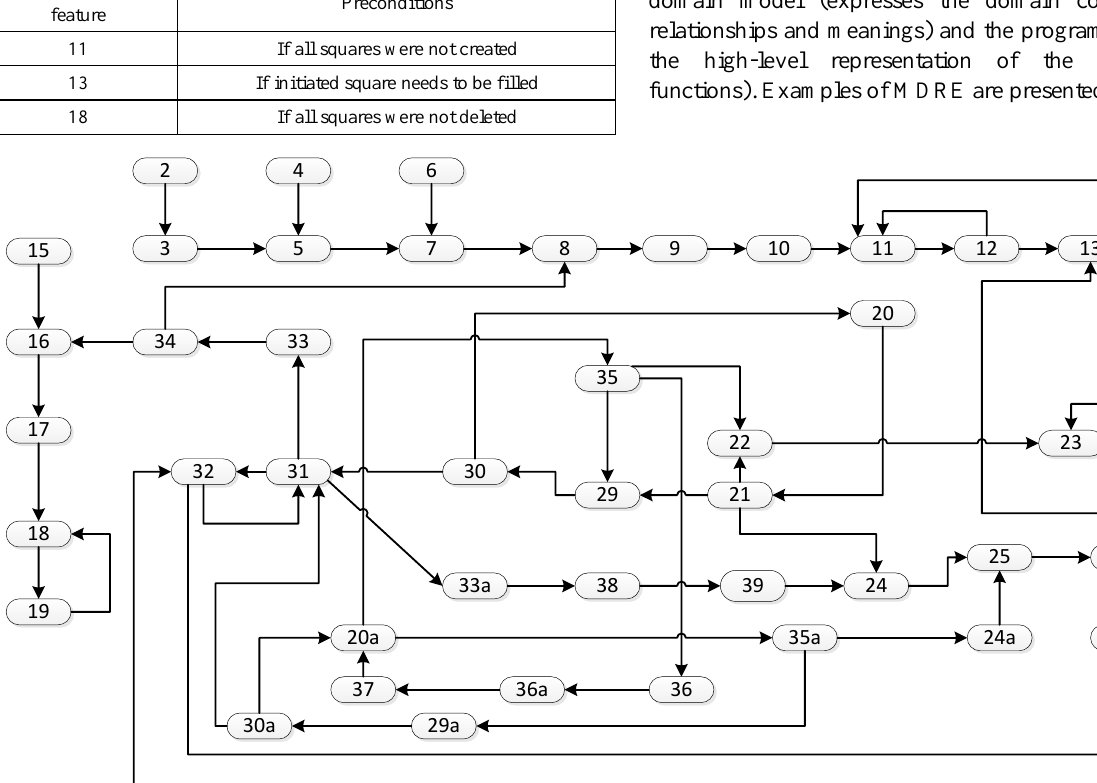
T HE P RECONDITIONS OF THE TFM F UNCTIONAL F EATURES The TFM functional feature